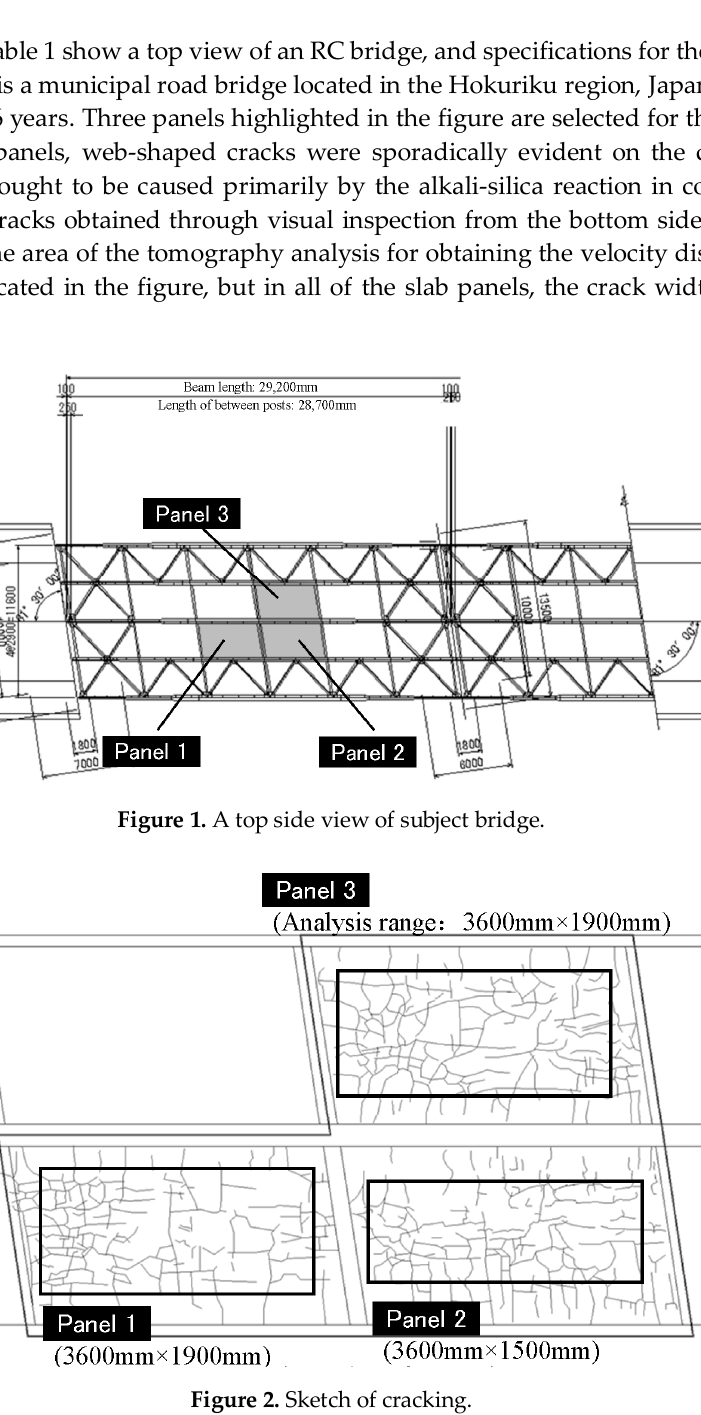
Figure 2. Sketch of